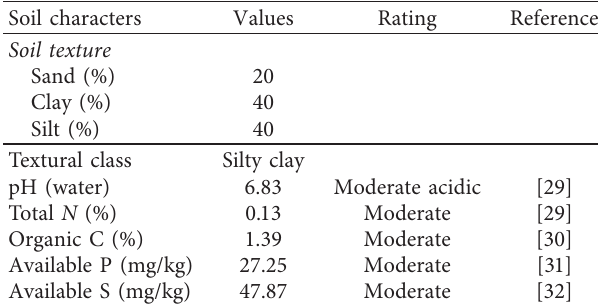
Table 1: Selected soil properties before